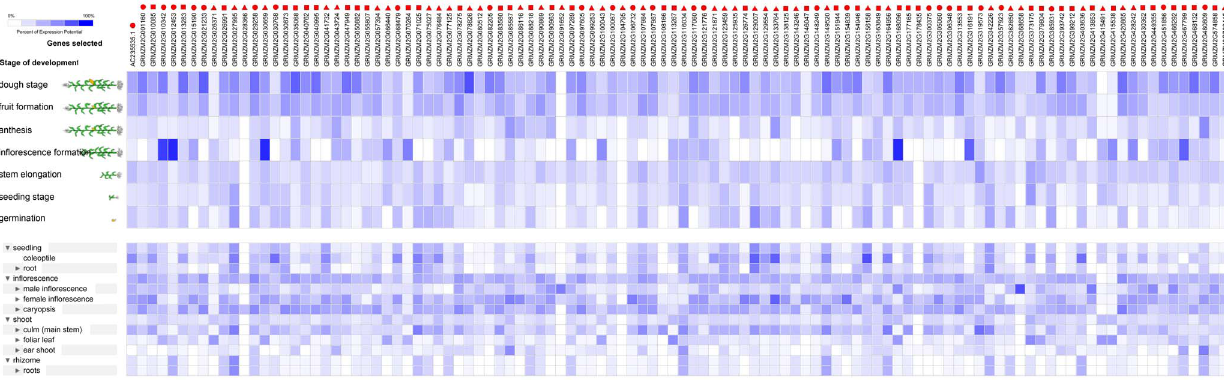
Figure 7. The expression profiles of 99 RNA helicase genes in Glycinemax . The expression profiles of 99 RNA helicase genes in different development stages (above) and different tissues (below) in Glycine max . The deep and light blue shading represents the relative high or low percent potential expression levels, respectively, of the helicase genes in different development sages and different tissues. The DEAD-box, DEAH-box and DExD/H-box RNA helicase genes are indicated by the red triangle, circle and square, respectively.